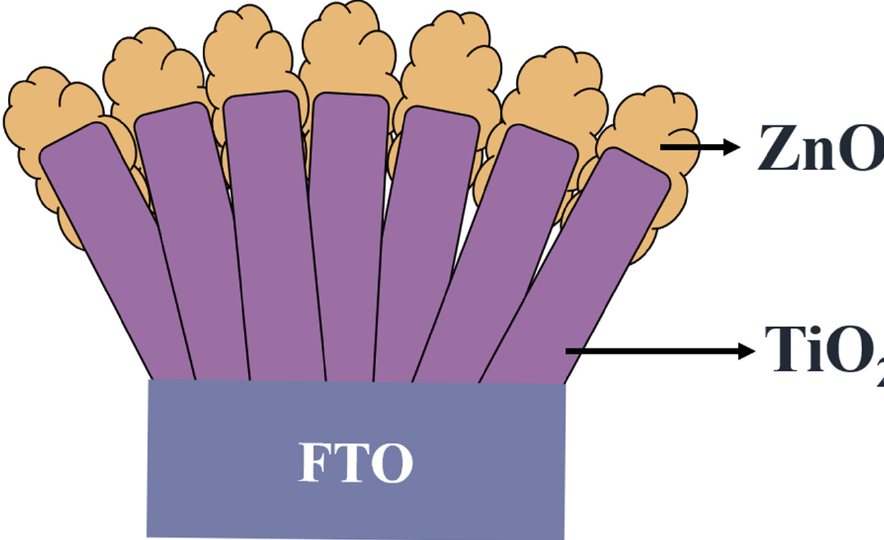
Figure 1. Schematic diagram of the TiO 2 –ZnO composite sample.